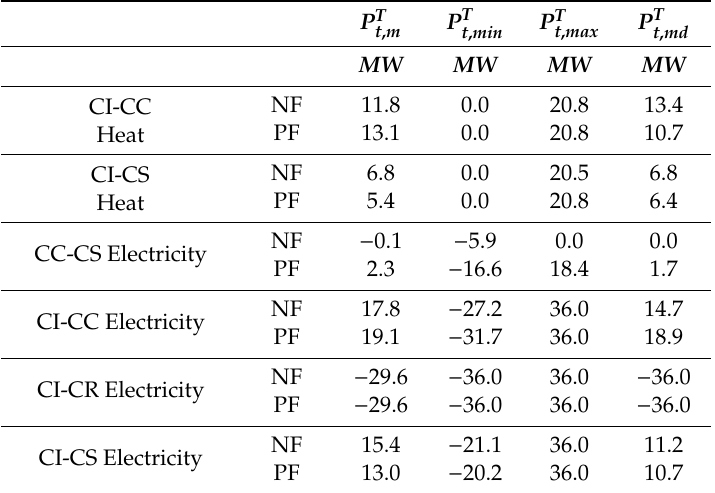
Table 9. Statistical analysis of the powerline and heat pipeline time series.